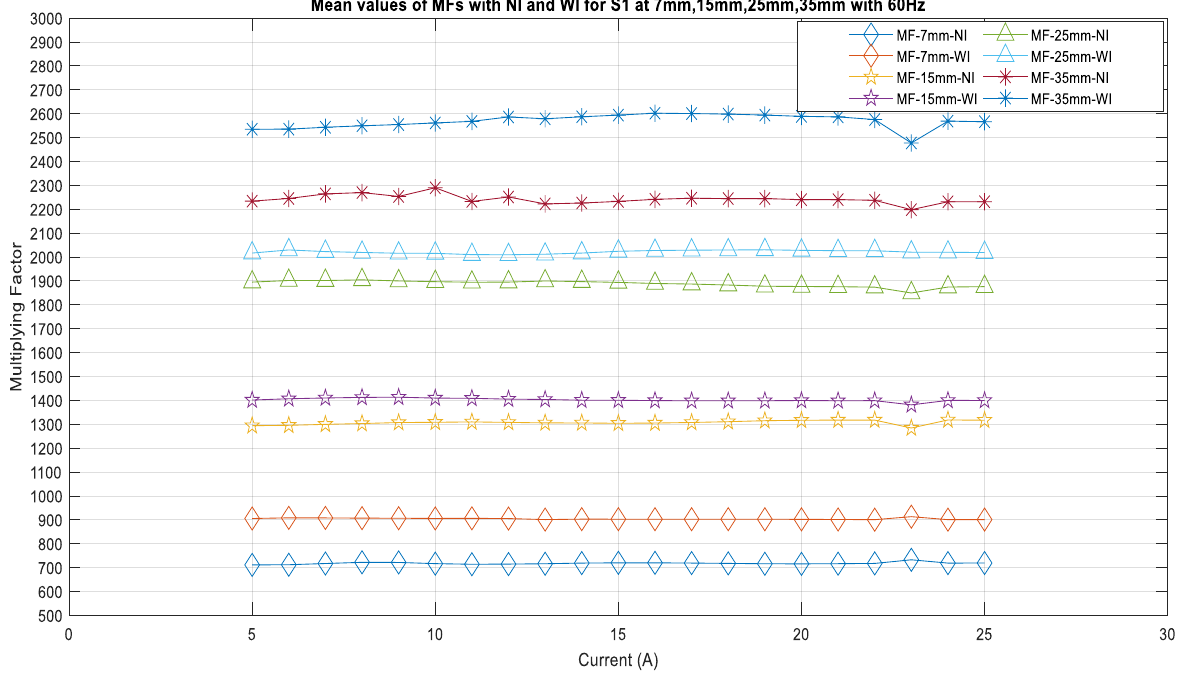
Figure 10. Multiplying factors of the sensor S1 for various distances.